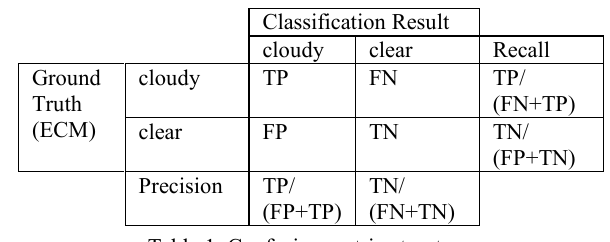
Table 1. Confusion matrix